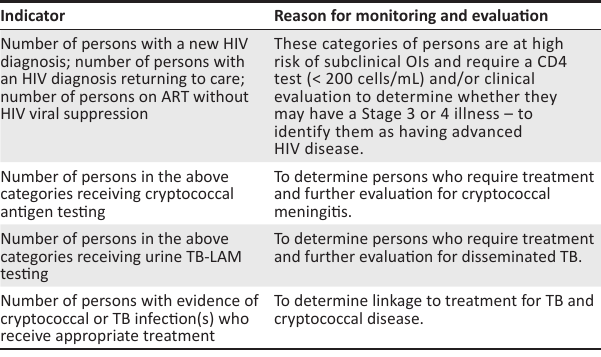
TABLE 1: The basic indicators for advanced HIV disease care. Indicator Reason for monitoring and